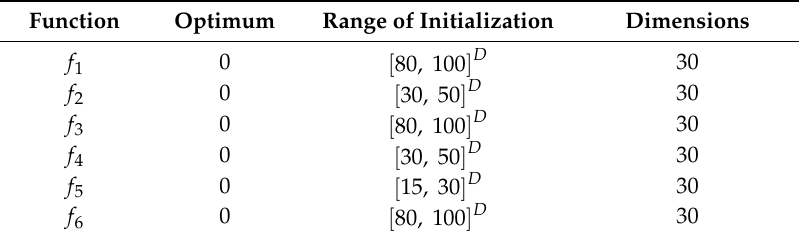
Table 3. Benchmark functions utilized for the experiments (optimum equal to zero).